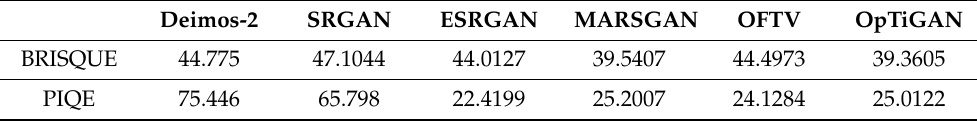
Table 5. BRISQUE and PIQE assessment of the Deimos-2 image and its SRR results at Baotou Geocal